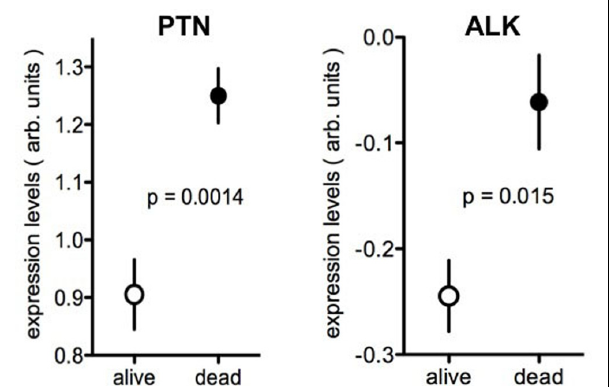
FIGURE 4 | Expression of PTN orALK in brain tumors in patients with different survival. Data from the Oncomine data base showing the expression levels of PTN (Phillips etal., 2006) or of ALK (Shai etal., 2003) in brain tumor samples.Tumor expression data were separated into those from patients alive or dead at 5 years (PTN) or 3 years (ALK) respectively. The data are presented as log values after normalization to the respective gene expression array and are shown as provided by Oncomine. Further studies are provided in Tables 1 and 2